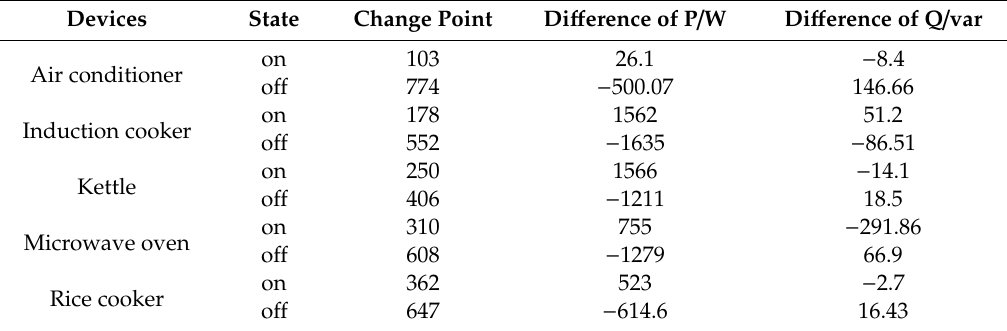
Table 4. Di ff erences on the load switching point.